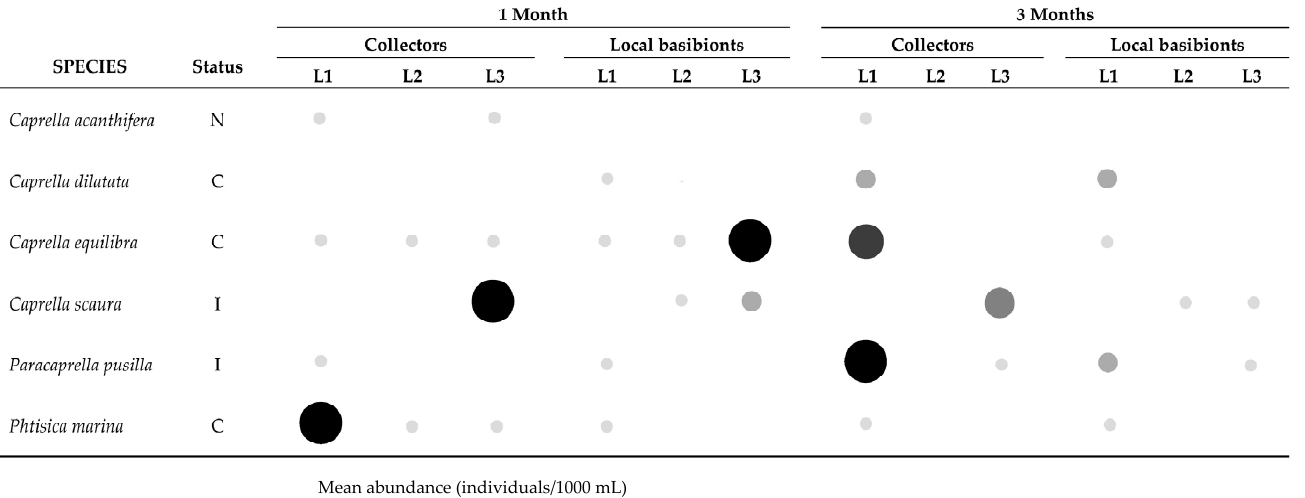
Table 2. Population density (individuals/1000 mL) of caprellid species found on the local basibionts and collectors for the two study periods (one month and three months, respectively, from the deployment of collectors) at each marina surveyed (Sancti Petri marina (L1), Rota marina (L2) and Puerto América marina (L3)). N: native species for the study area. I: introduced species in the study area. C: cryptogenic species. 1